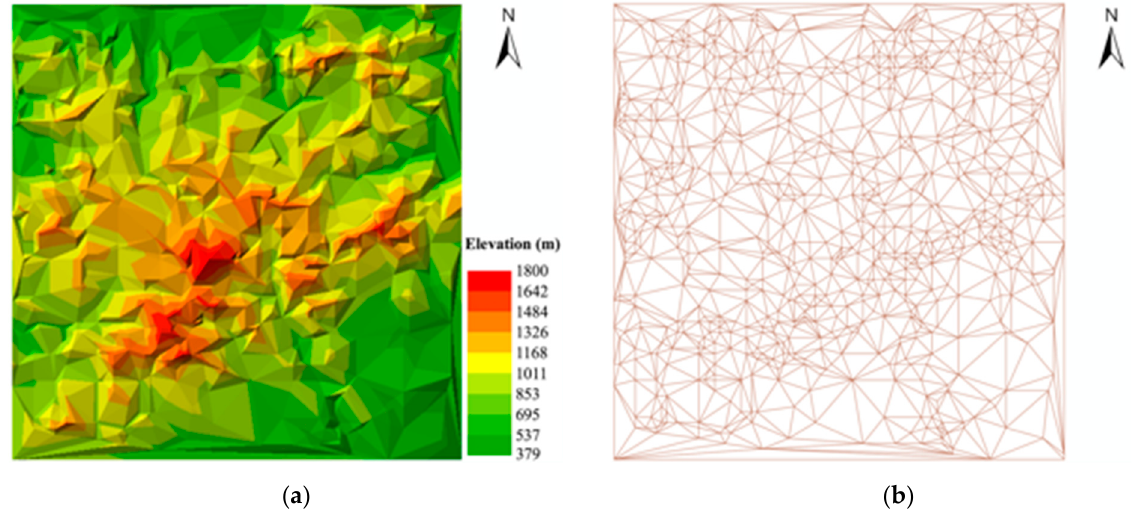
Figure 4. The experimental data. ( a ) The TIN DEM data; ( b ) the edges of the TIN DEM data.